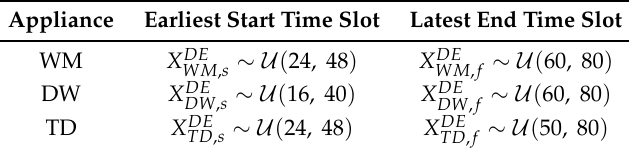
Table 2. The user preferences for the related DE appliances’ schedule.